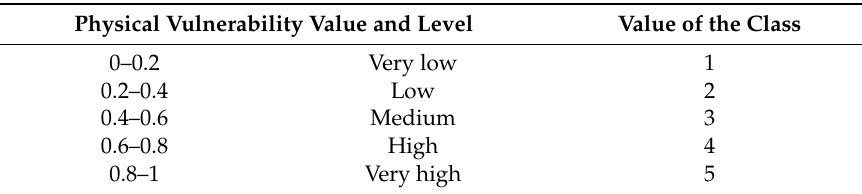
Table 4. Classification of physical vulnerability calculated at the BGRI